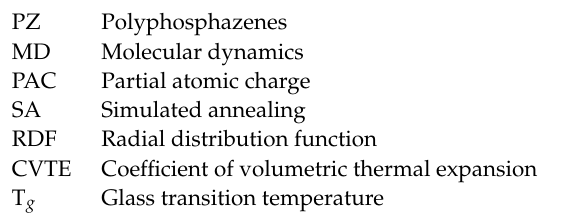
atomic sites for the PZ-Nitrato (the labels corresponding to Figure S1). Table S5. Bond length and bond force constants used for relaxing newly formed bonds between the monomers for each